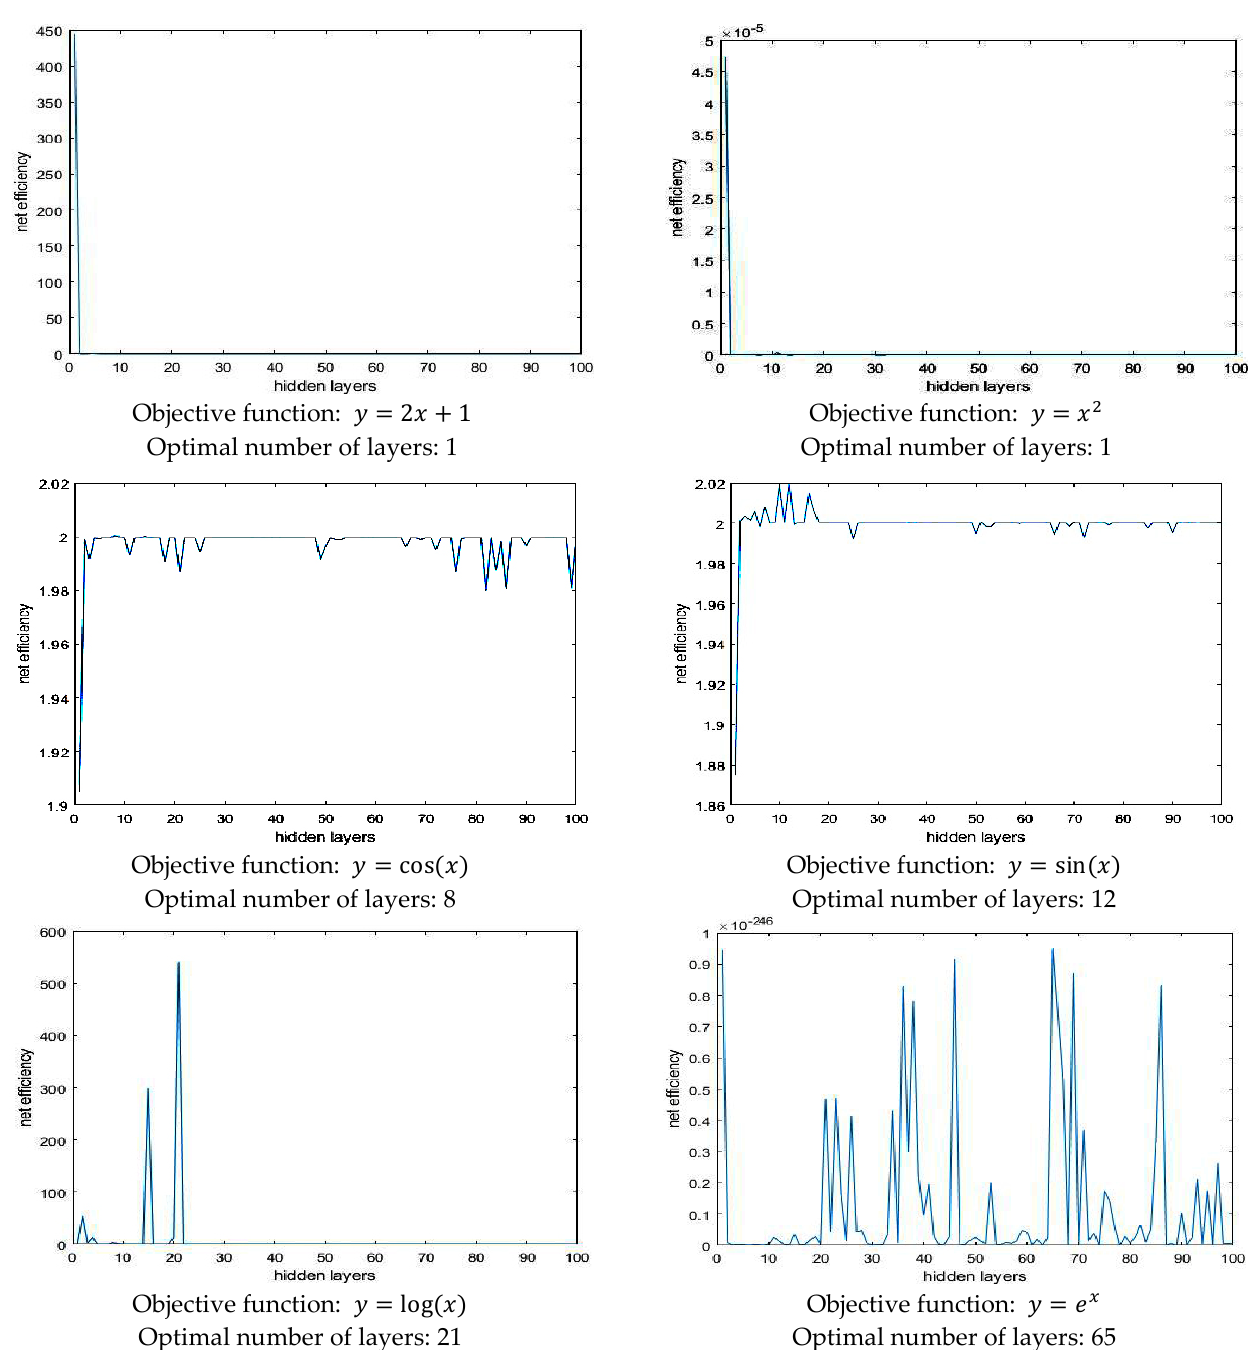
Figure 1. Efficiency of neural networks in the studied objective functions for a number of layers from 1 to 100 and 3 neurons in each layer.